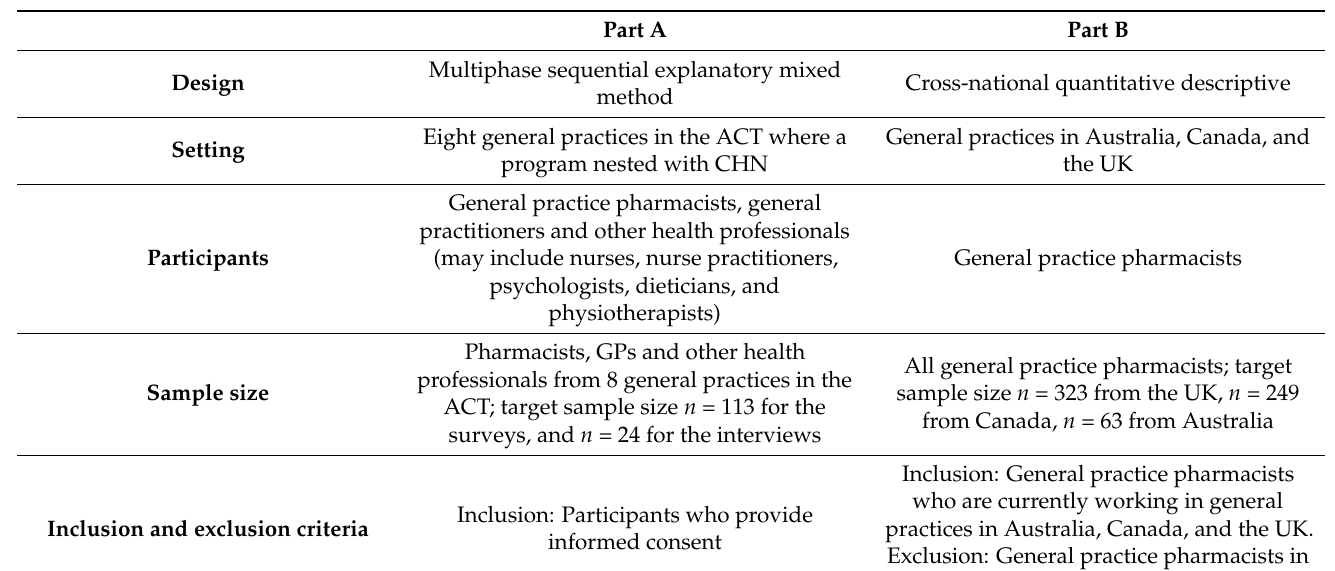
Table 1. Summary of the study